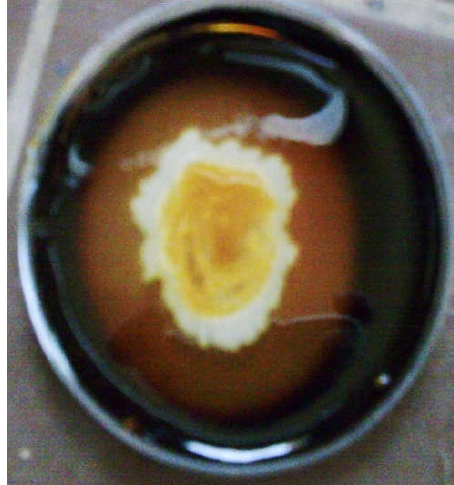
Fig. 1. Phylogenetic tree of Bacillus mojavensis UMF29 based on 16S rDNA sequences of related strains. Scale bar, 0.02 represents nucleotide substitutions per site.